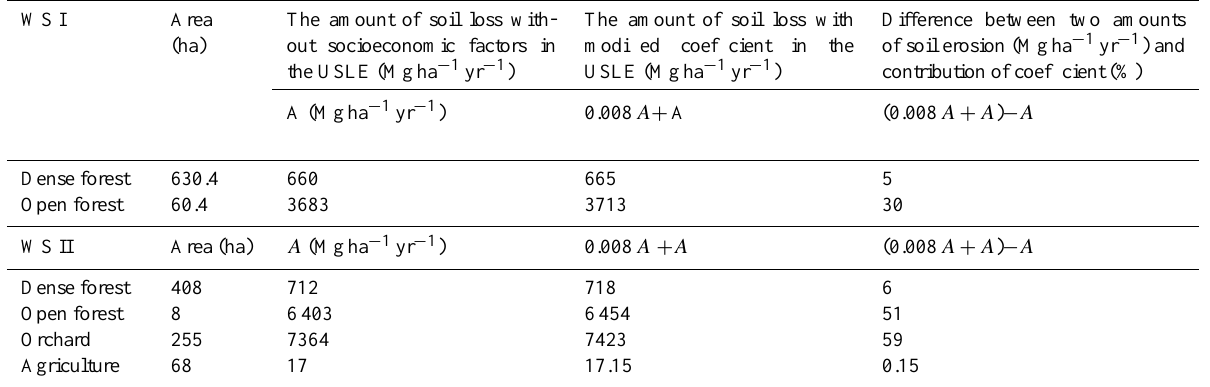
Table 4. The amount of soil loss without and with modified coefficient in the USLE. The amount of soil loss with Difference between two amounts WS I Area The amount of soil loss with- of soil erosion (Mgha − 1 yr − 1 ) and modified coefficient in the (ha) out socioeconomic factors in contribution of coefficient (%) USLE (Mgha − 1 yr − 1 ) the USLE (Mgha − 1 yr − 1 ) A (Mgha − 1 yr − 1 ) 0.008 A + A (0.008 A + A ) − A Dense forest 630.4 660